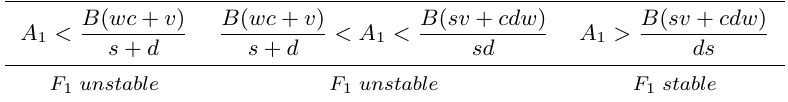
Table 1. Stability intervals for F 1 , setting A 1 = A + 1 > 0. B ( wc + v ) A 1 < s +